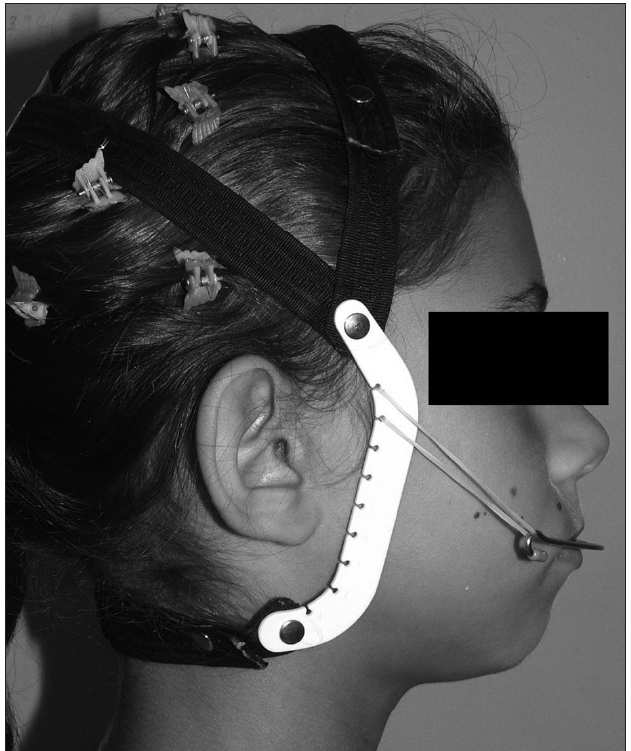
Figure 2. Interlandi occipital pull.